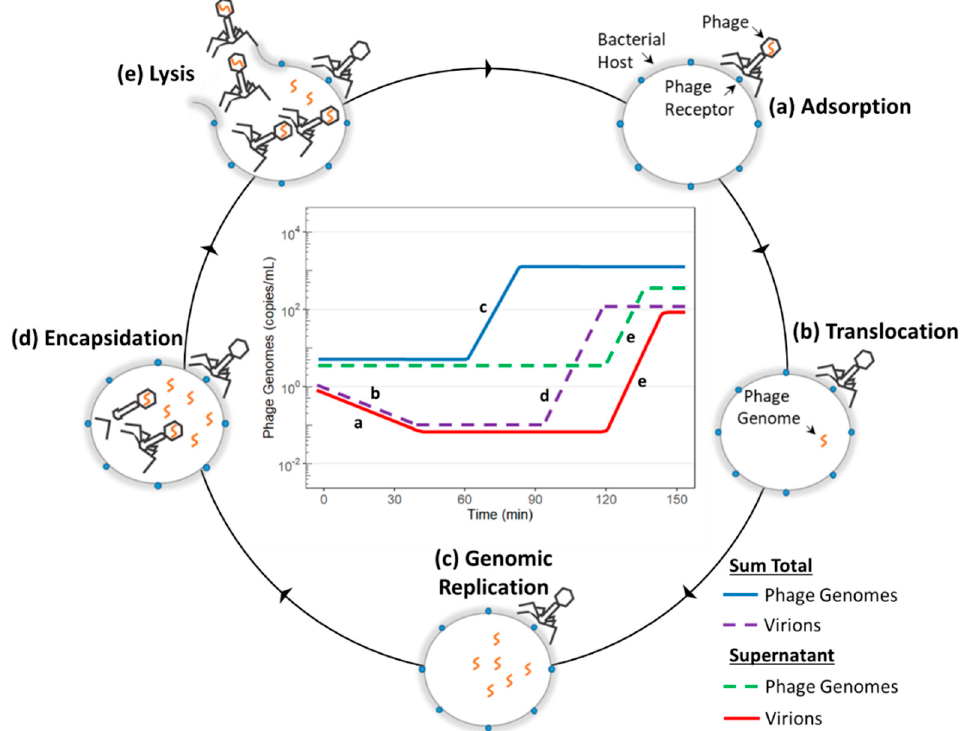
Figure 2. Transition states of the phage genome through the lytic cycle and their associated curves in a simulated molecular profile of phage infection. ( a ) Adsorption of the phage into the bacterial hosts leads to a decrease in the number of virions in the supernatant. ( b ) Ejection of the phage genome into the host leads to a decrease in the total number of phage particles. ( c ) Replication of the phage genome leads to an increase in the total number of phage genomes. ( d ) Expression of phage structural proteins leads to phage genome encapsidation and an increase in the overall number of virions. ( e ) Lysis leads to an increase in the number of virions and phage genomes in the supernatant.